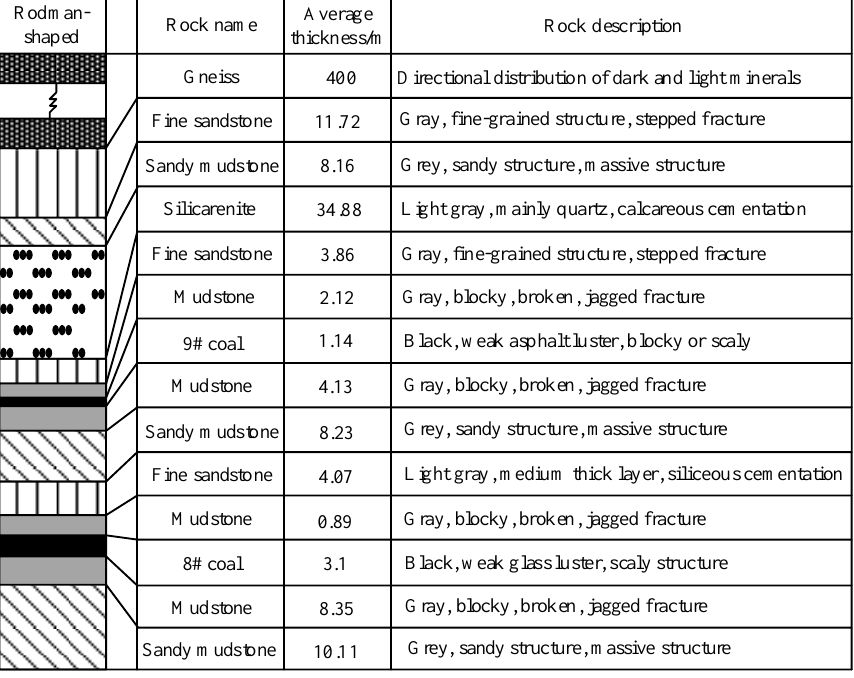
Figure 3. Rock stratum histogram.